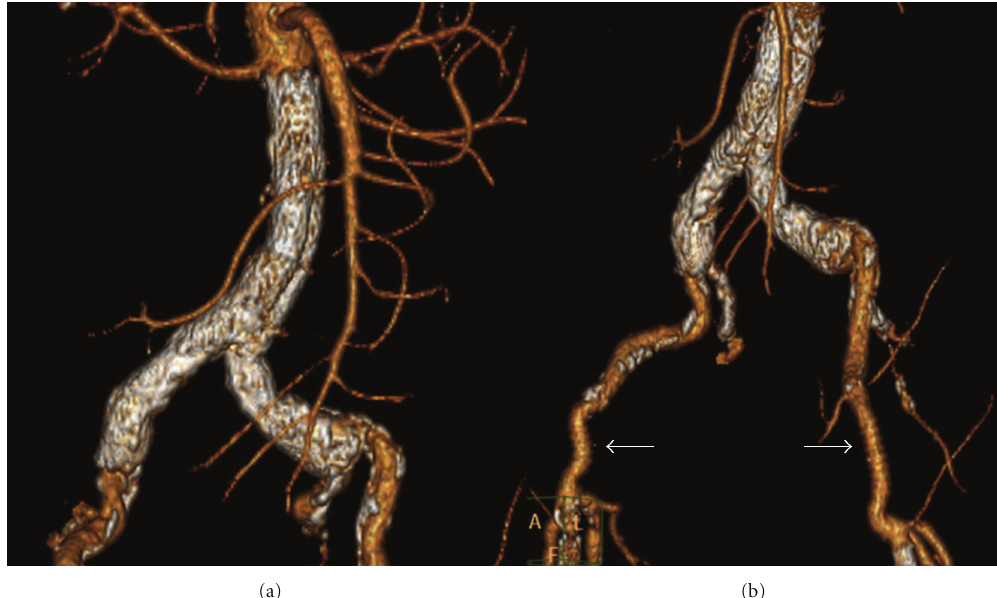
Figure 2: Six-month postprocedural computed tomography angiography revealing (a) the successful deployment of the aortic graft and (b) the patent femoral-femoral PTFE grafts (white arrows).